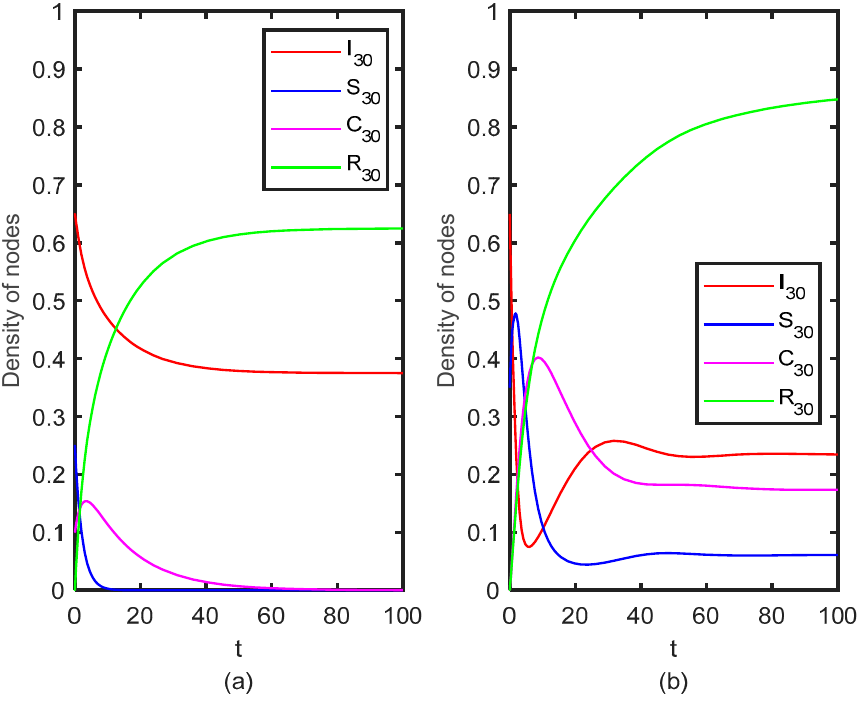
Figure 2. The densities of I 30 ( t ) , S 30 ( t ) , C 30 ( t ) , R 30 ( t ) , ( a ) R 0 < 1, ( b ) R 0 >